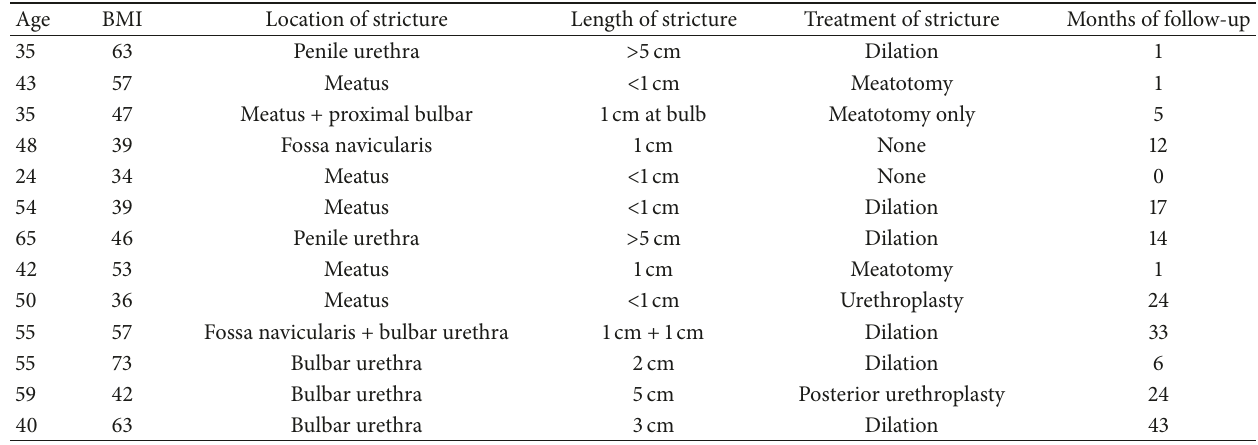
Table 2: Patients with urethral